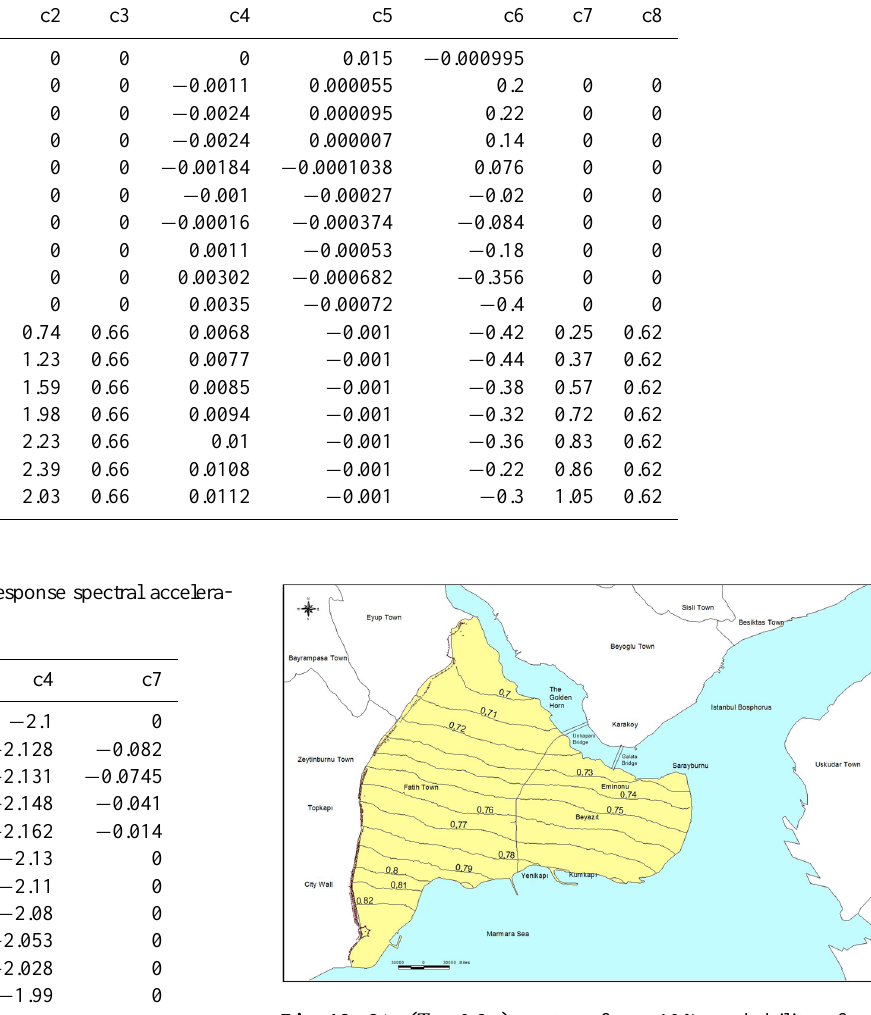
Fig. 12. SA ( T = 0.2s) contour for a 10% probability of ex- ceedance in 50yr for the Historical Penninsula of Istanbul (Pois- sonian model) (˙Ince,